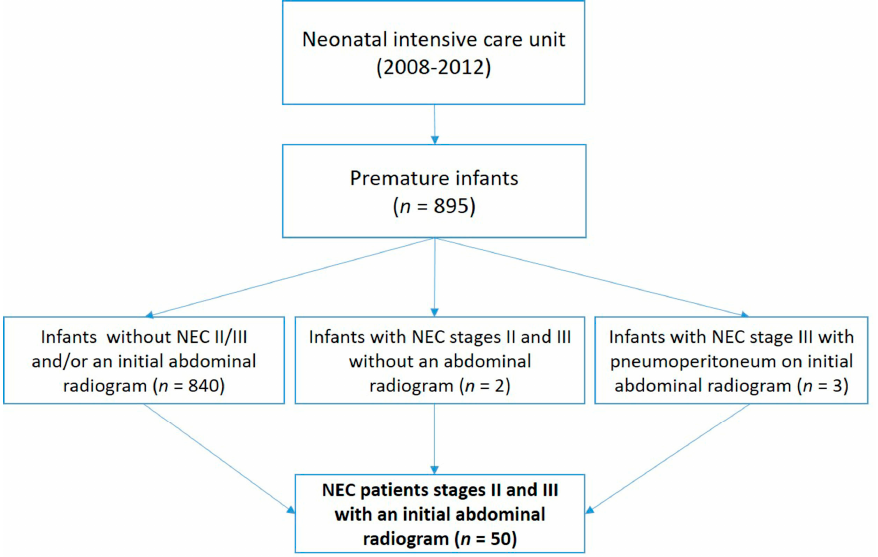
Figure 1. A flowchart that shows the selection of the necrotizing enterocolitis (NEC) patients for the current study.